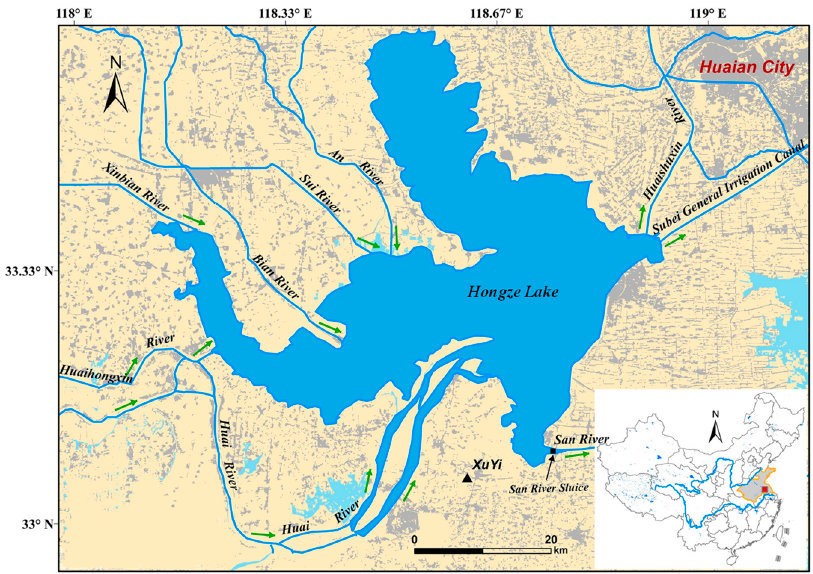
Figure 1. Hongze Lake water system map.